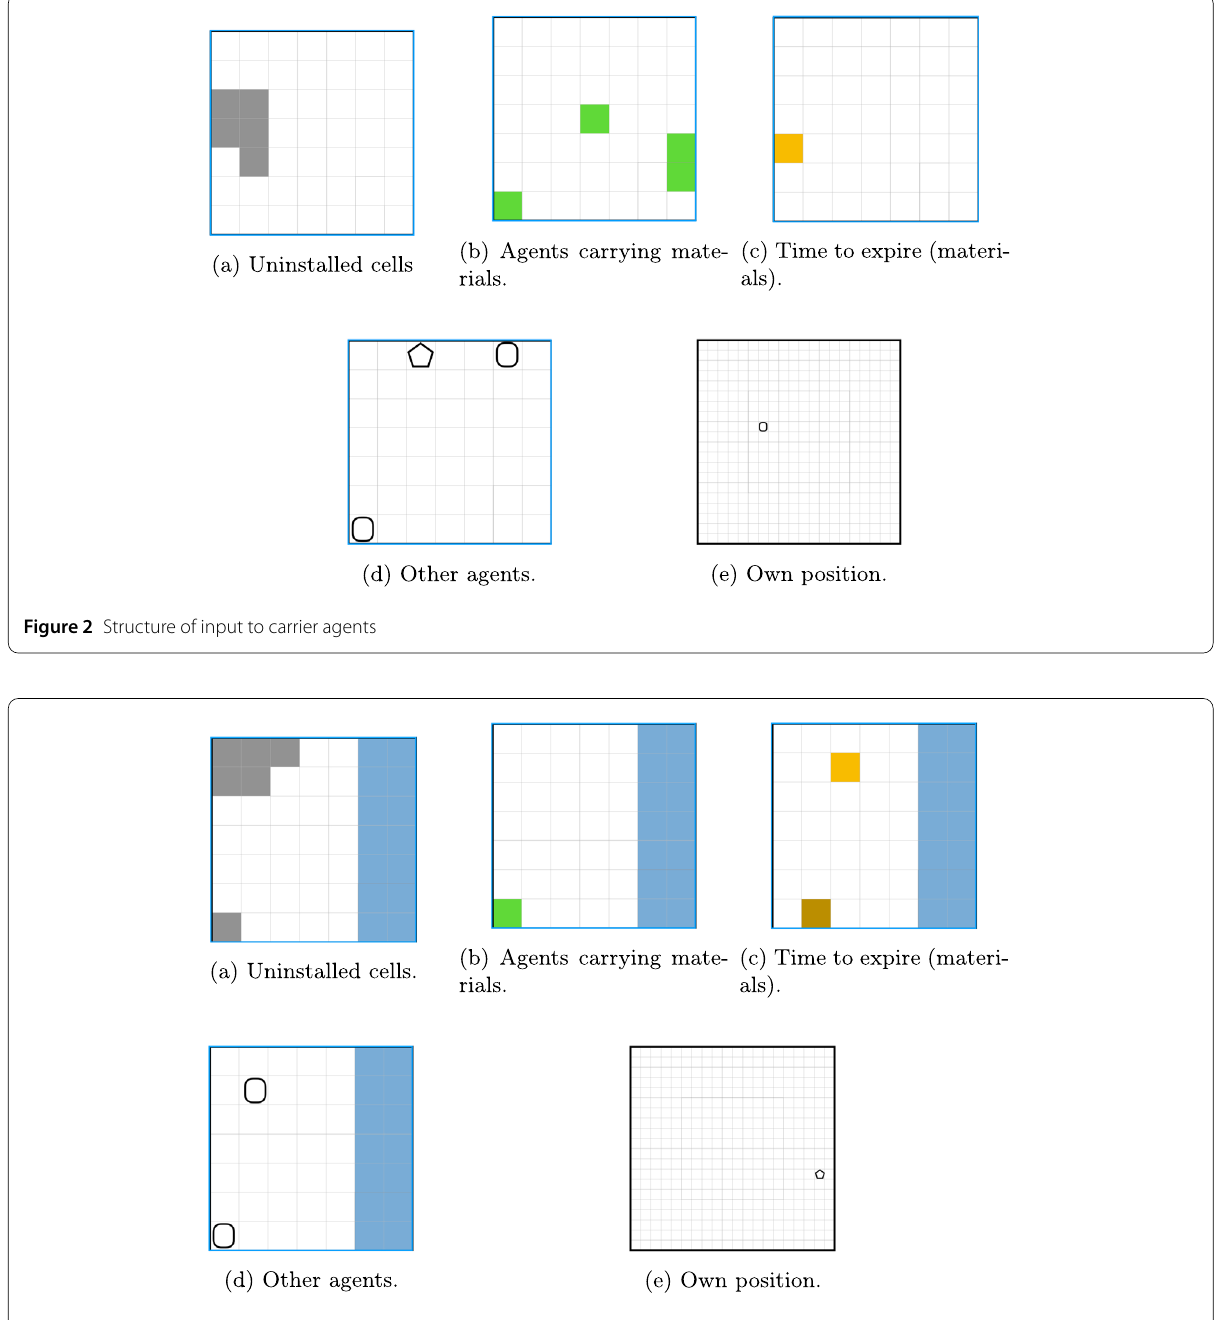
Figure 3 Structure of input to installation agents